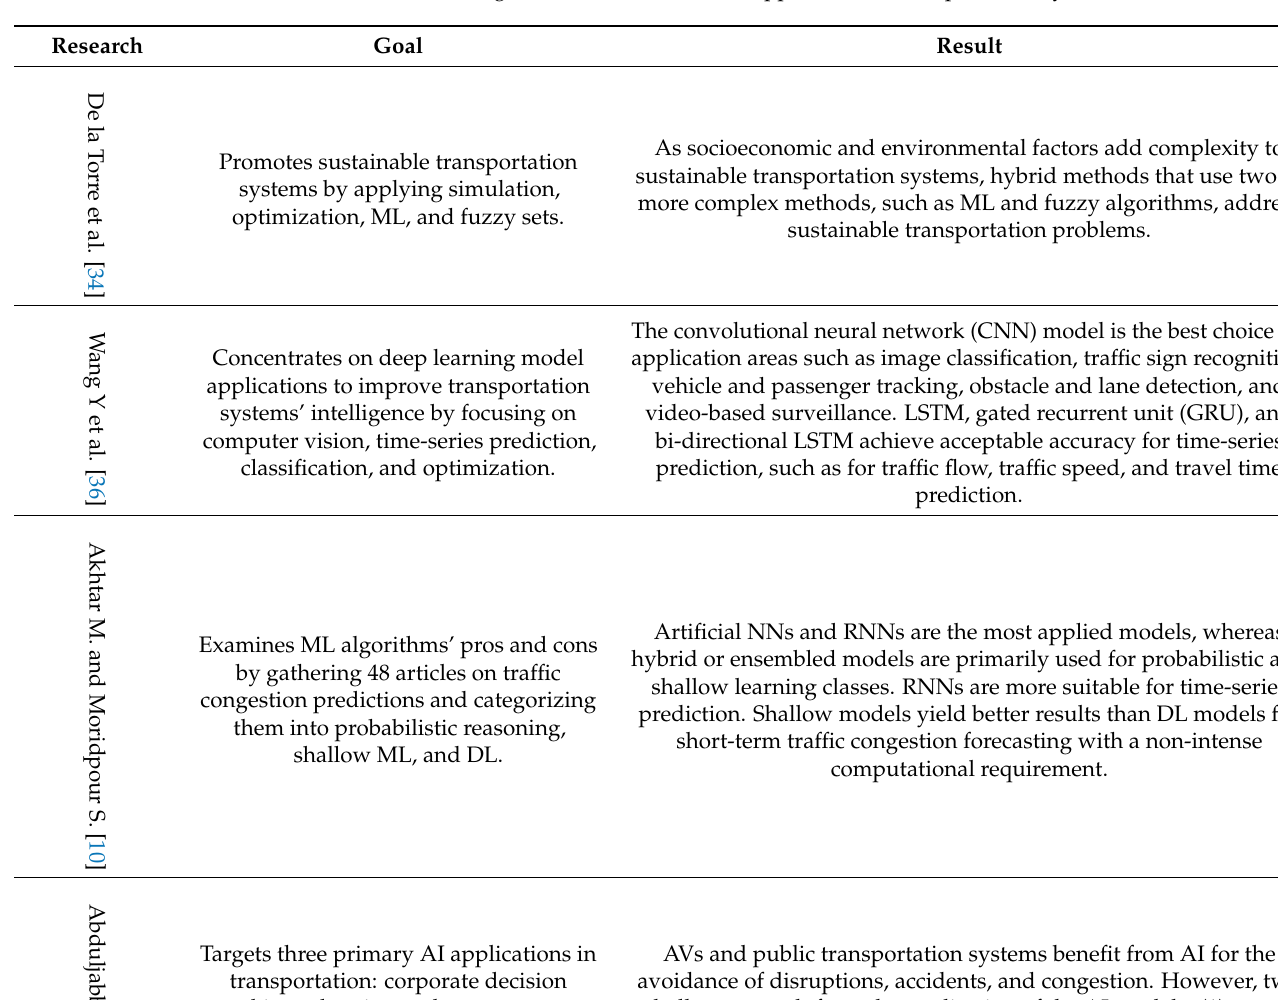
Table 1. Existing literature reviews on AI application in transportation